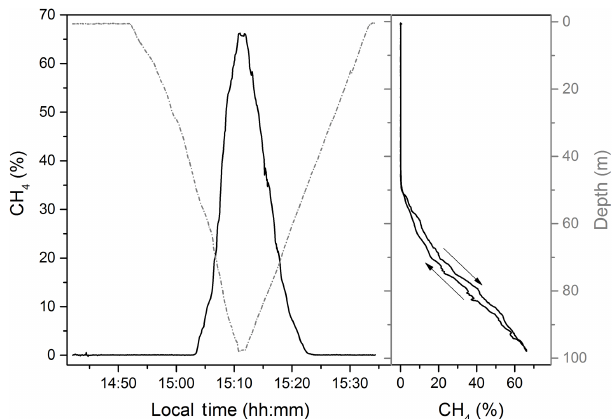
Figure 4. One of the continuous methane profiles recorded by the Sub-Ocean on 10 March 2018. The concentration is expressed as a percentage of CH 4 with respect to the total dissolved gas. The 100m downward and upward profile was recorded in 42min. On the right panel the two profiles are superposed, highlighting the re- producibility of the measurement between descent and ascent.